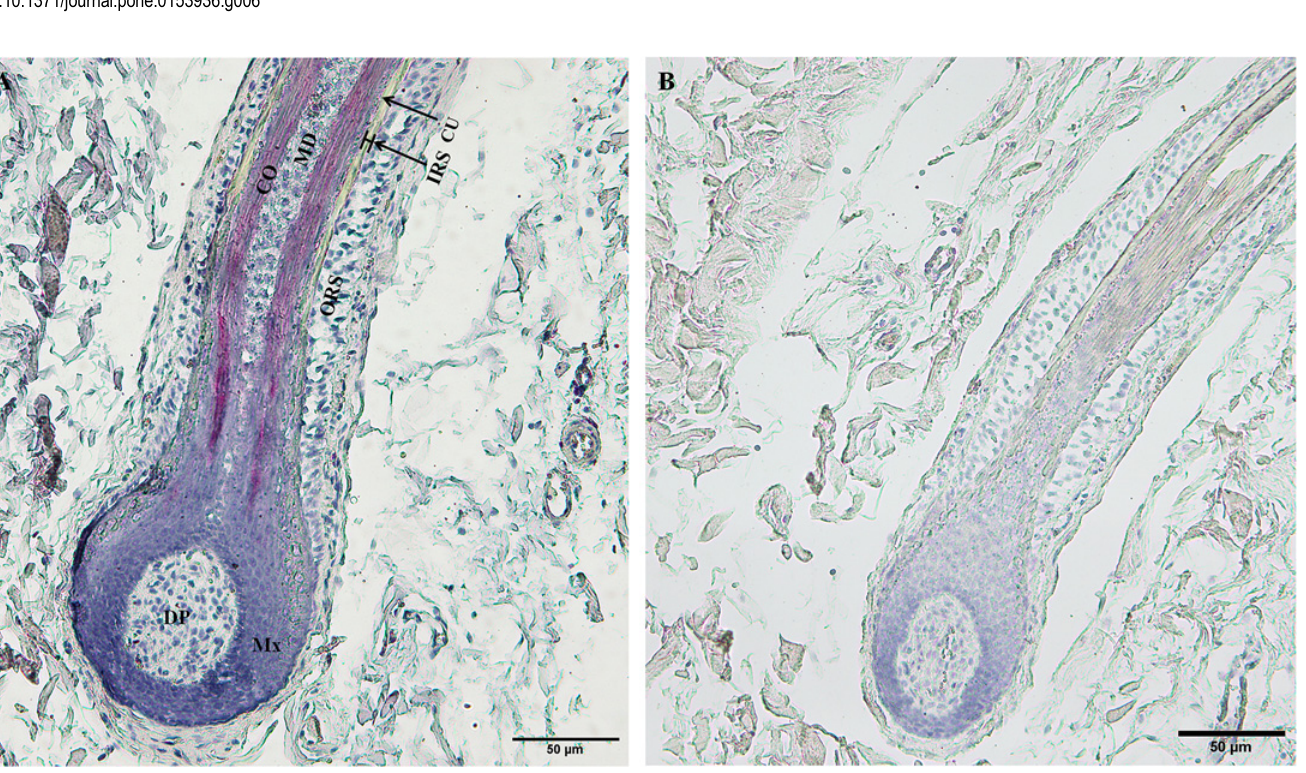
Fig 7. Localization of KRTAP11-1 mRNA in wool follicles of the Tibetan sheep. (A) Red staining indicates that the expression of the KRTAP11-1 gene is present in the hair cortex during the anagen phase. (B) Negative control. DP: dermal papilla; IRS: inner root sheath; ORS: outer root sheath; CO: cortex; CU: cuticle; MD: medulla. Scale bars = 50 μ m (A, B).